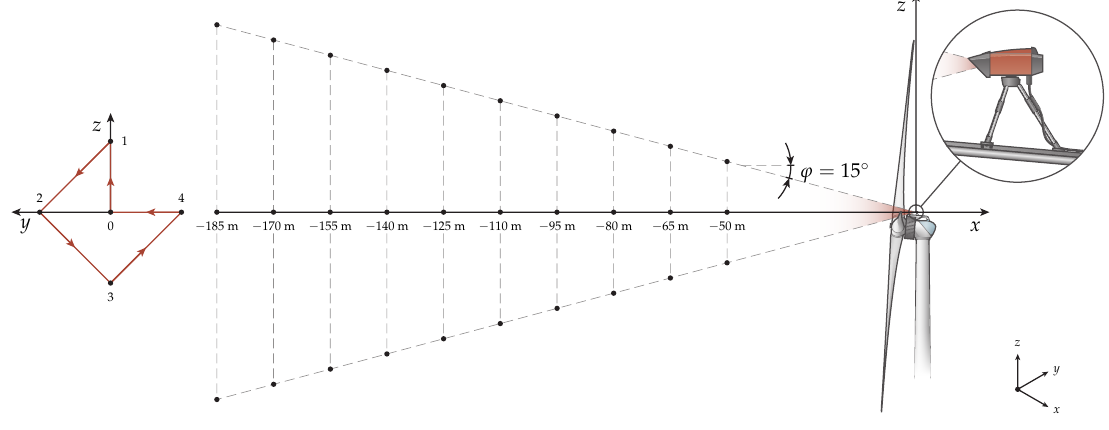
Figure 1. Drawing of the pulsed lidar system, mounted on the nacelle of a Darwind XD115-5MW wind